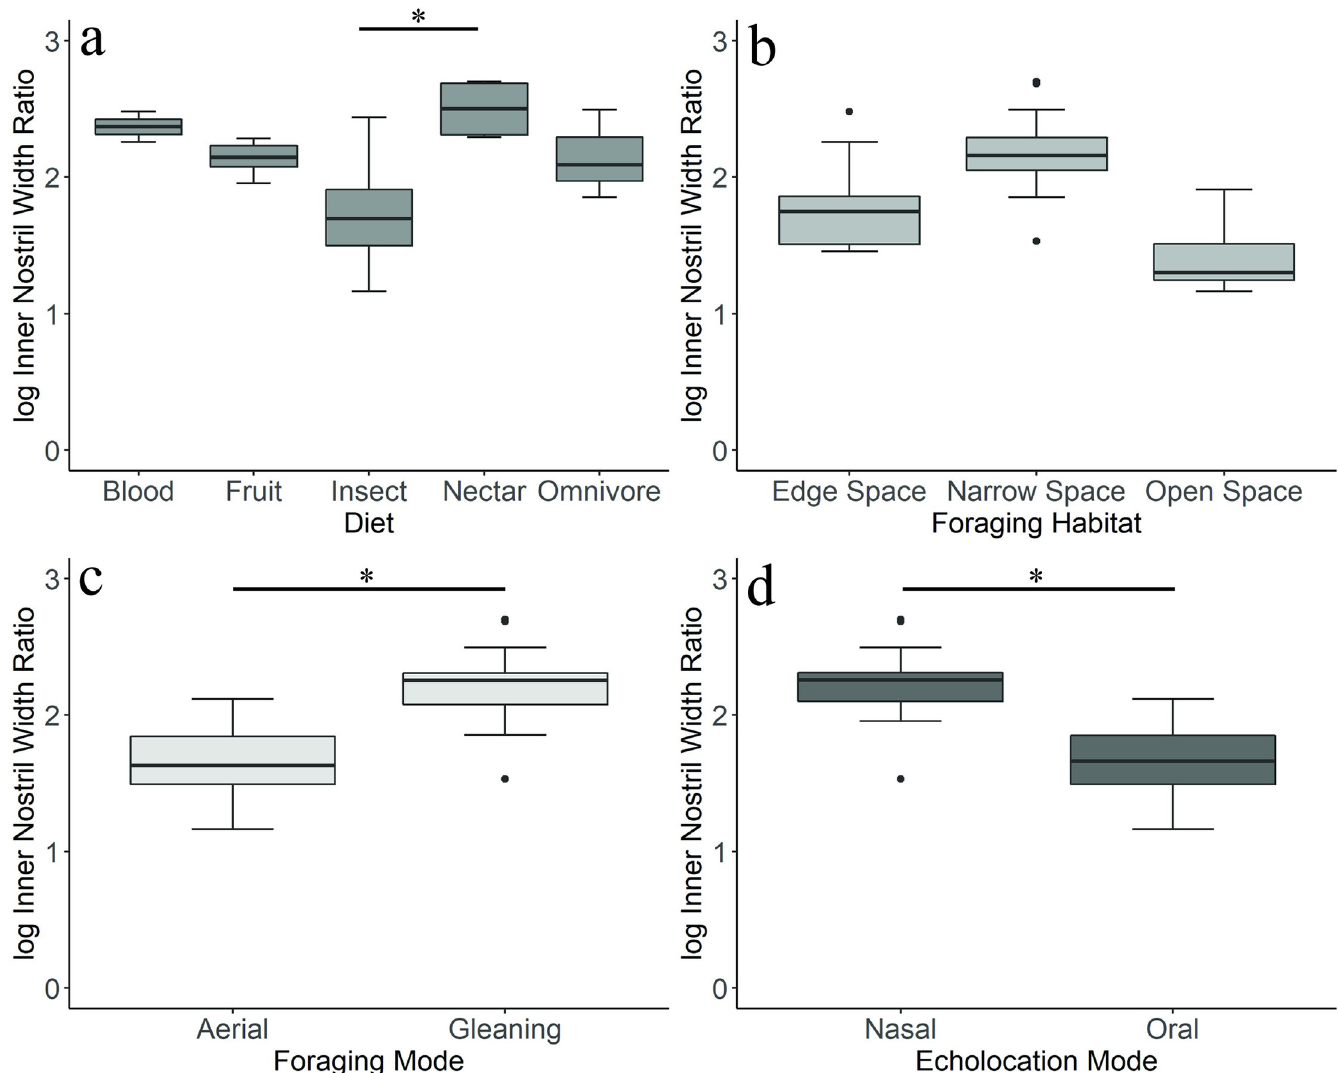
Fig 7. Boxplots representing variation in inner nostril width ratio (INWR). Data from the full dataset for four of the measured ecological variables: diet ( a ), foraging habitat ( b ), foraging mode ( c ), and echolocation mode ( d ). Asterisks indicate statistical significance in a phylogenetic ANOVA.